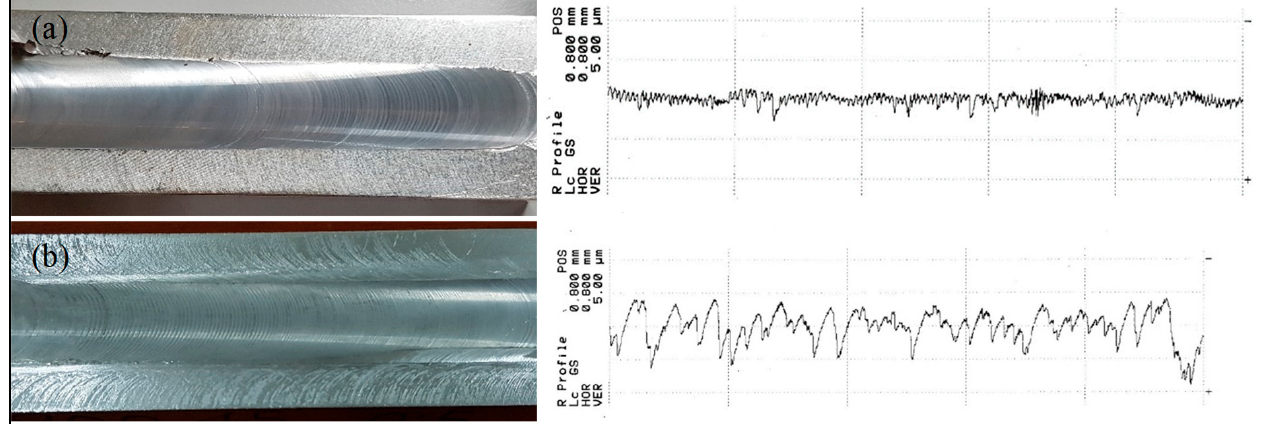
Figure 11. FSPed surface and roughness profile of ( a ) sample 7 and ( b ) sample 18.